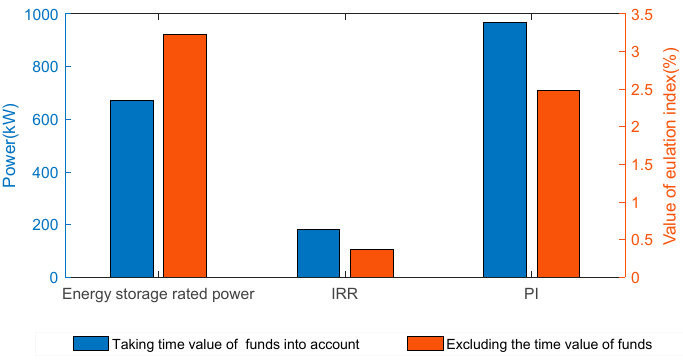
Figure 11. Comparison in configuration results and economic indexes. IRR: internal return rate; PI: profit